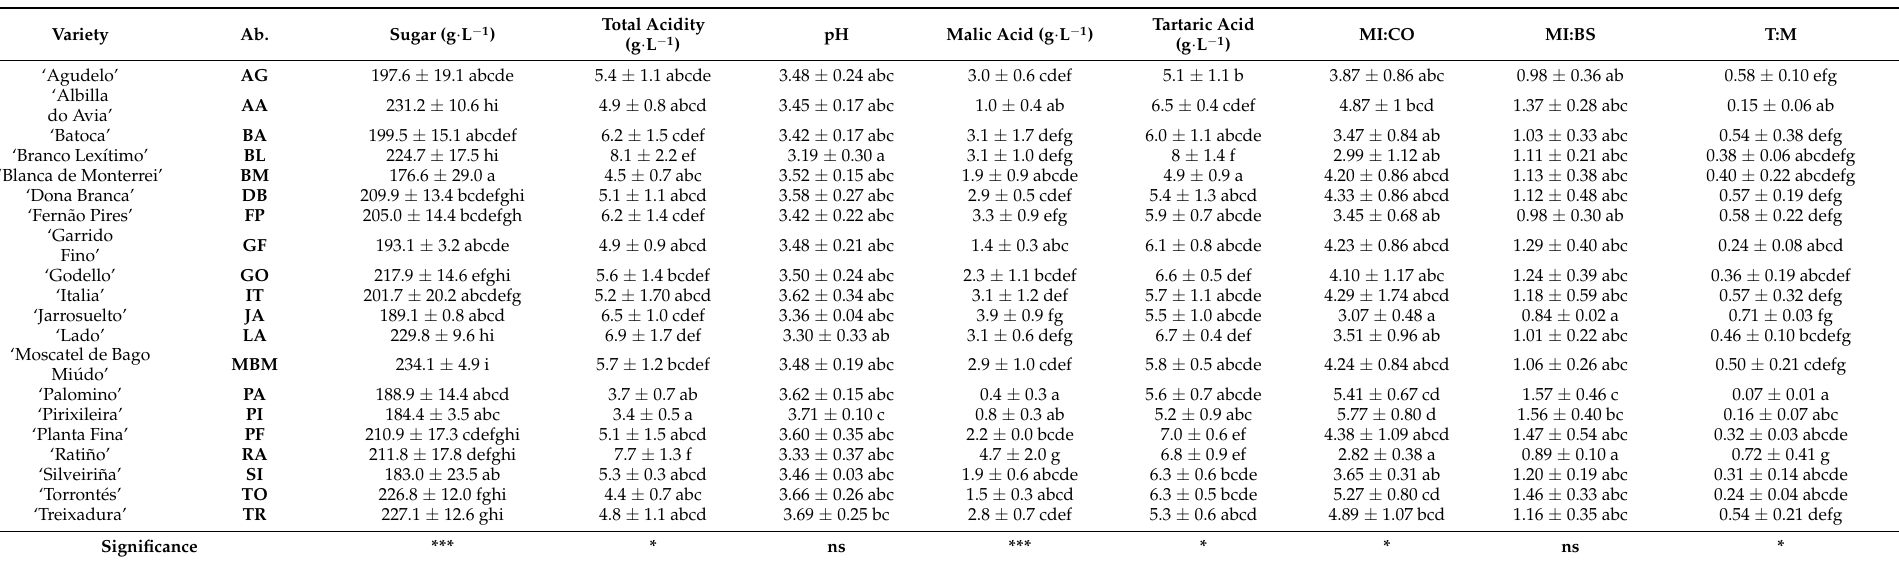
Table 1. Chemical composition of the grapes in the three vintages studied